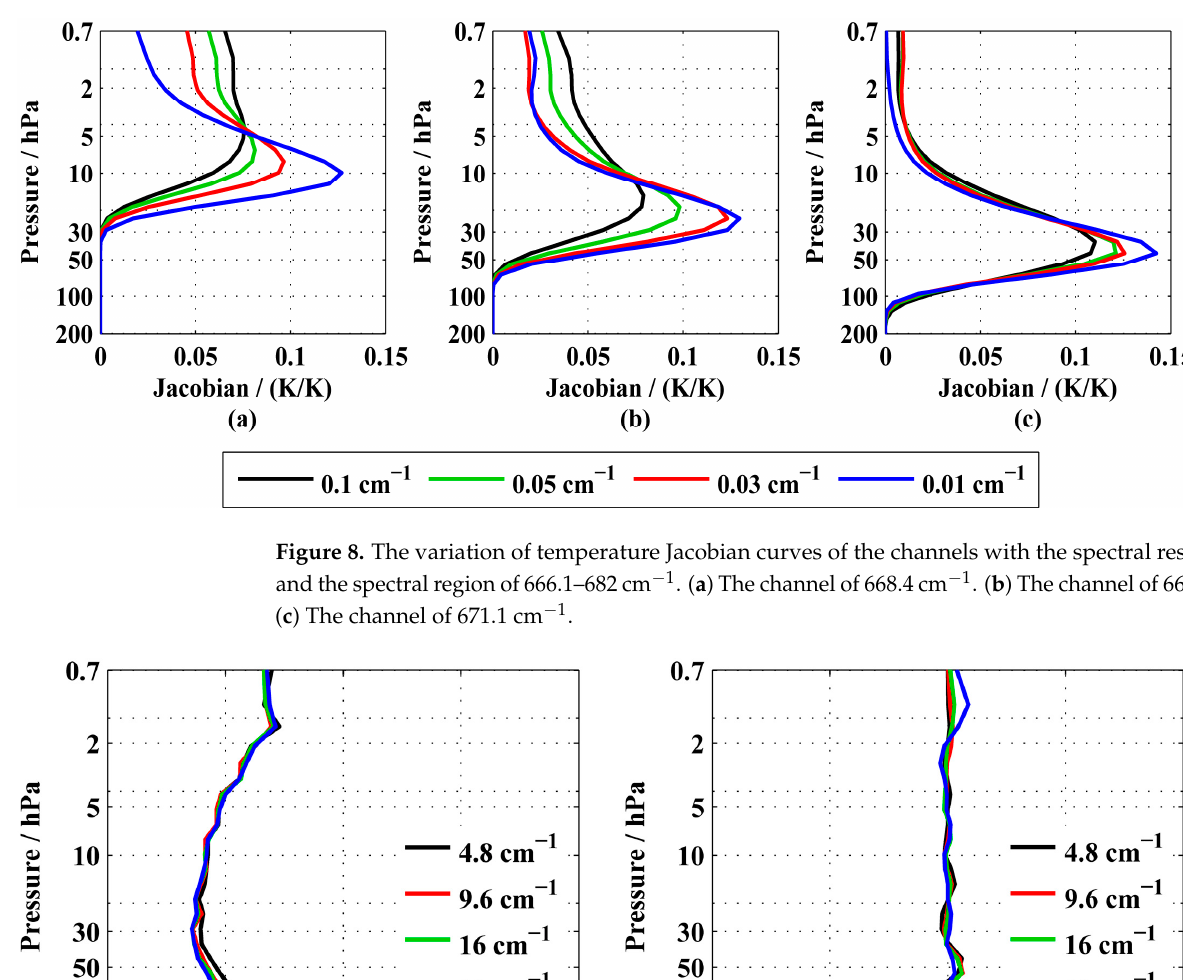
Figure 7. The temperature Jacobian peak corresponding to atmospheric pressure with di ff erent spectral resolutions and the same spectral region of 666.1–682 cm − 1 . ( a ) A spectral resolution of 0.1 cm − 1 . ( b ) A spectral resolution of 0.05 cm − 1 . ( c ) A spectral resolution of 0.03 cm − 1 . ( d ) A spectral reso-